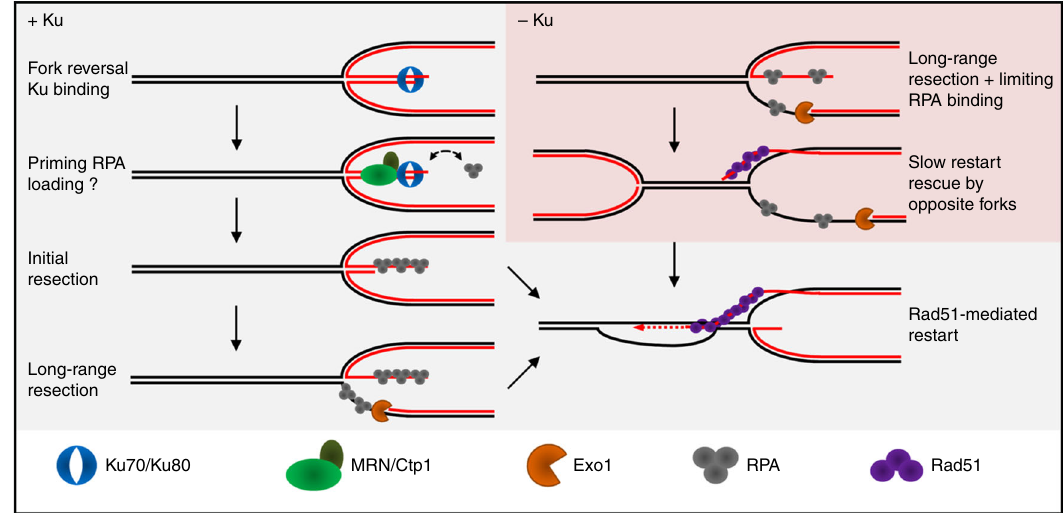
Fig. 8 Model of two-step resection of DSB-free arrested forks regulated by Ku. In wt cells, DSB-free arrested forks undergo fork reversal providing a single DNA end for Ku binding. MRN-Ctp1 allows Ku removal, generating a 110 bp sized ssDNA on which Rad51 nucleates to promote strand invasion within the restored parental duplex. The initial fork-resection primes the Exo1-mediated long-range resection. Through direct or indirect physical interactions, Ku may be recruited in association with RPA to facilitate its loading on ssDNA. In the absence of Ku, the reversed arm is directly resected by Exo1 resulting in an extensive fork-resection. Possibly, this may destabilize the reversed fork and impact the recruitment of HR